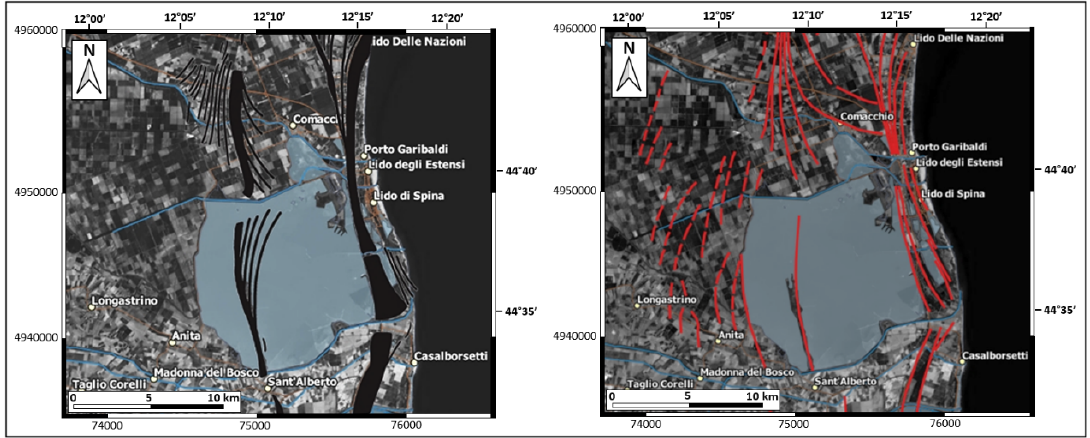
Figure 14. Distribution of most prominent barriers and ridges in the Valli di Comacchio area, as described in [57], left, and [66], right map.